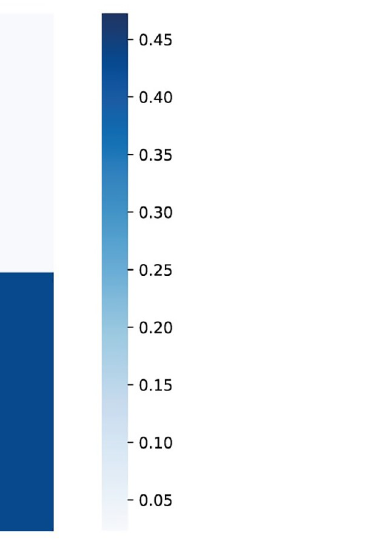
Fig 7. Confusion matrix showing accuracy of random forest classifier on test